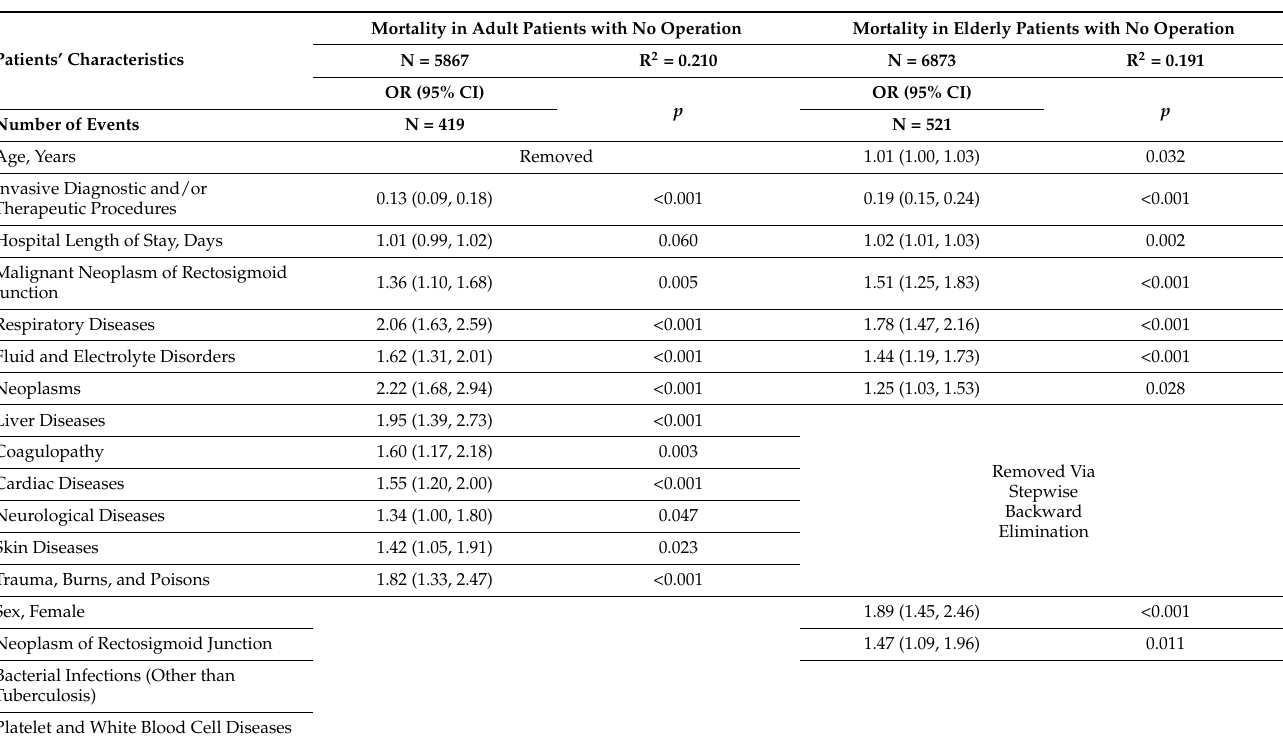
Table 6. Backward logistic regression analysis to evaluate the associations between mortality and different factors in patients emergently admitted with a primary diagnosis of malignant neoplasm of rectum or rectosigmoid junction and not undergoing an operation (NIS 2004–2014). Mortality was the dependent